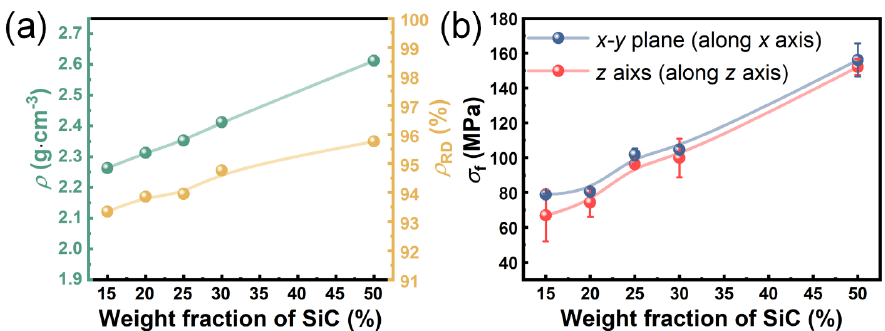
Fig. 6 (a) Densities and relative densities of SiC/GF composites with different SiC concentrations. (b) Flexural strengths of the composites in two principle directions.